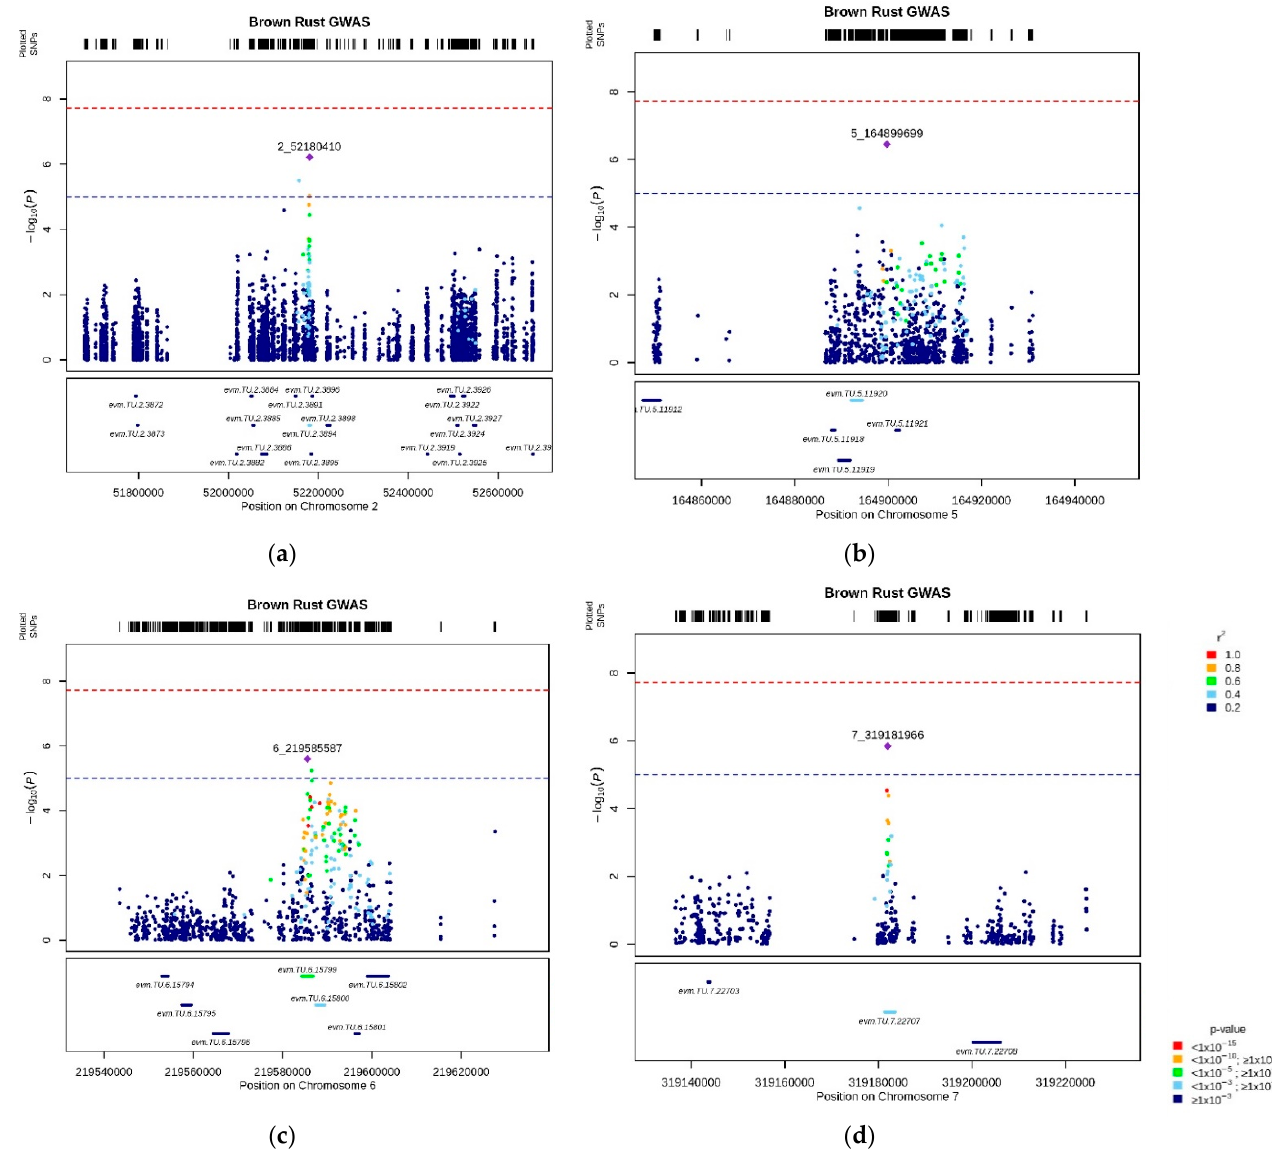
Figure 5. LocusZoom plots of the most highly associated QTL to BRR. Plots show the regions around the most significant SNPs. SNPs are plotted as the − log 10 of the p -value (box on the top). The LD.Measure function from LDcorSV R-package [33] was used to estimate the linkage disequilibrium ( r 2 ) between the most significant marker in that region and all the markers within a 100 Mbp window; each SNP’s r 2 is color-coded, as well as the p -value of the genes measured through MAGMA analysis (box on the bottom). The red dotted line refers to the Bonferroni threshold, while the blue horizontal line indicates the arbitrary cutoff of -log 10 ( p -value) = 5. Each plot refers to the association of BRR to BR-QTL2 ( a ), BR-QTL5 ( b ), BR-QTL6 ( c ), BR-QTL7 ( d ), respectively.